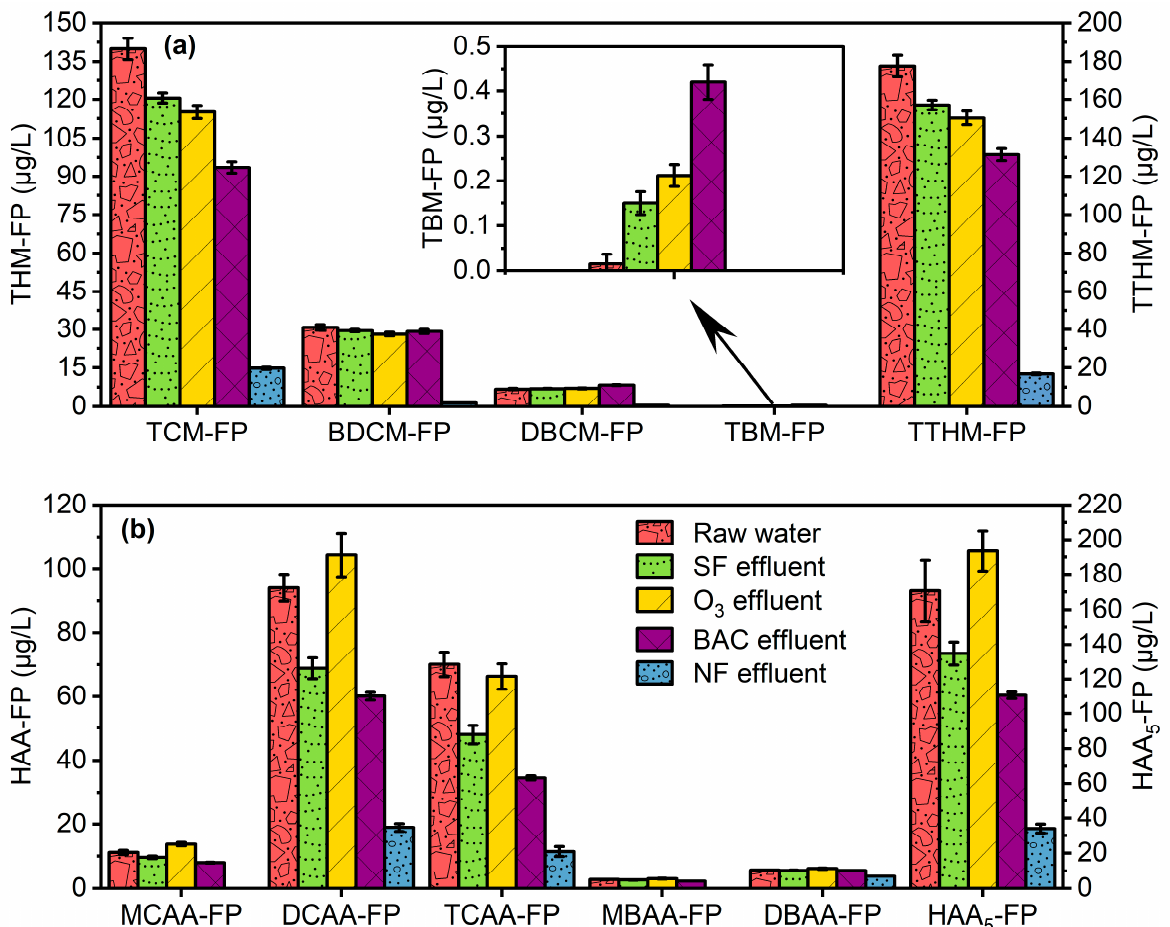
Figure 3. Measurements of DBP formation potentials in samples of the raw water and effluents of each treatment unit: ( a ) THM-FP (including TTHM-FP and individual species) and ( b ) HAA 5 -FP (including HAA 5 -FP and individual species). Samples were collected for THM-FP analysis on March 18 2021, and for HAA 5 -FP analysis on 11 January 2021. Error bars represent standard deviations obtained from three independent assays for each sample.